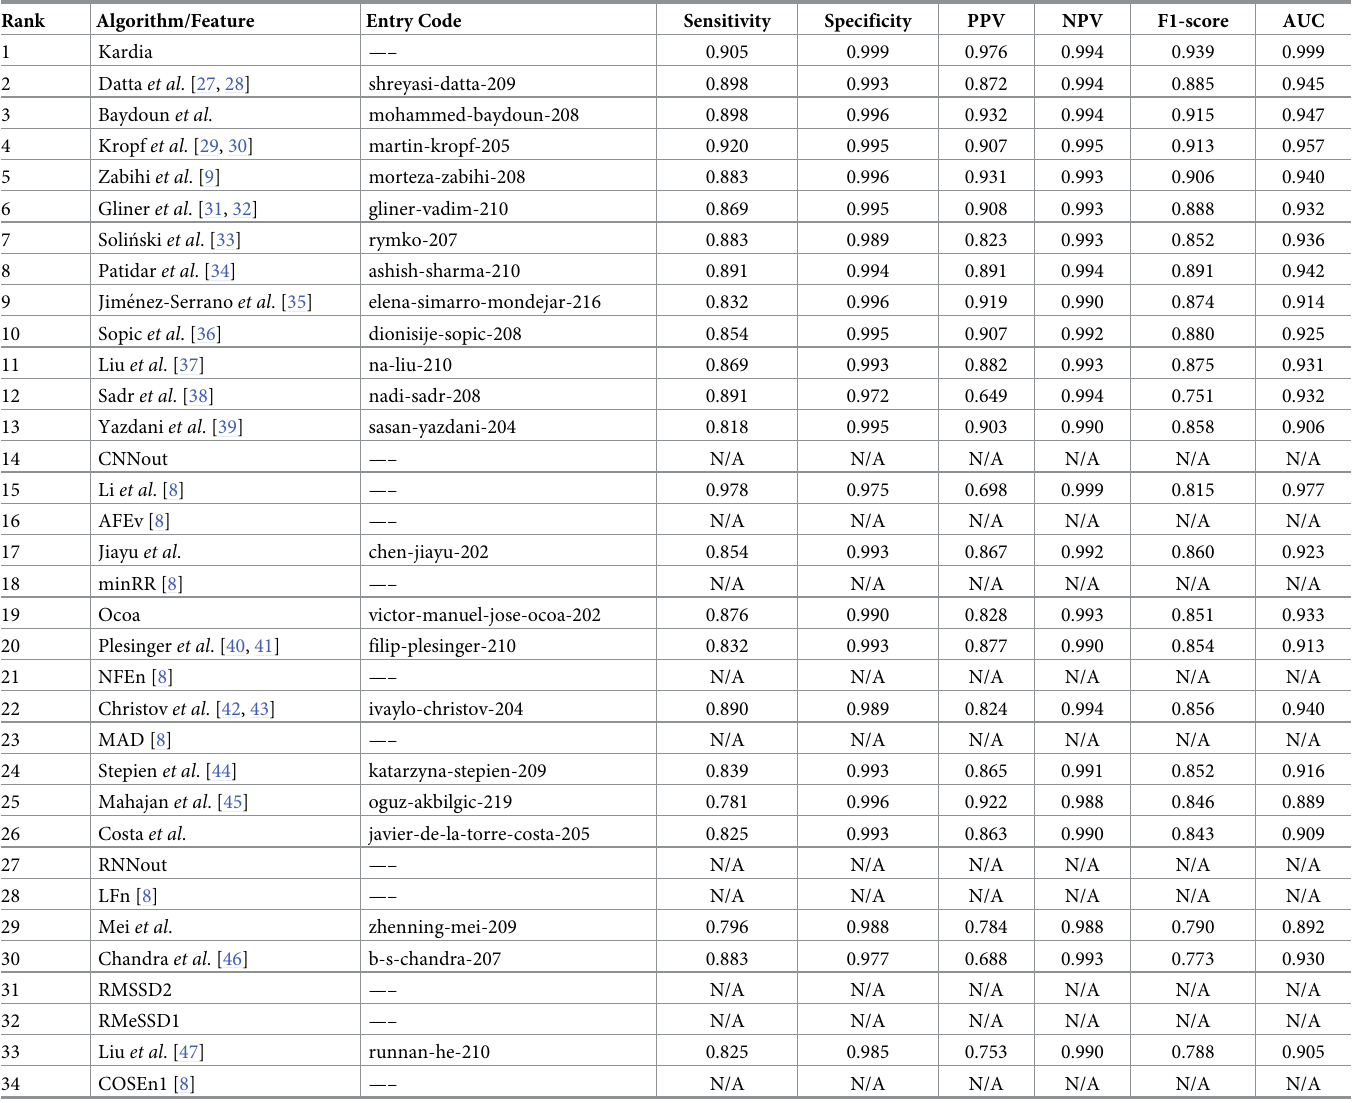
Table 1. The 38 base-level algorithms and the 24 ECG features were ranked using a random forest classifier. The detailed descriptions of the features are described in Methods. The classification results of the 38 algorithms on the training dataset are also listed. For features the corresponding locations of classification results are filled with N/A (i.e., not applicable). The source codes and their related papers can be found in